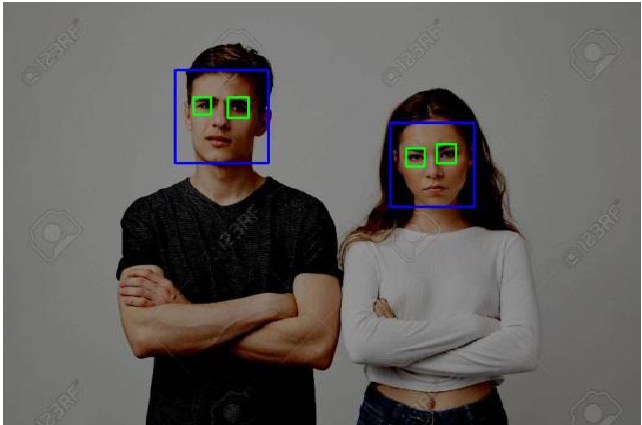
Figure 40. After decreasing the brightness of Figure 38.